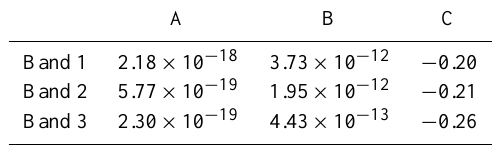
Table 4. Coefficients of the simple GOSAT noise model,